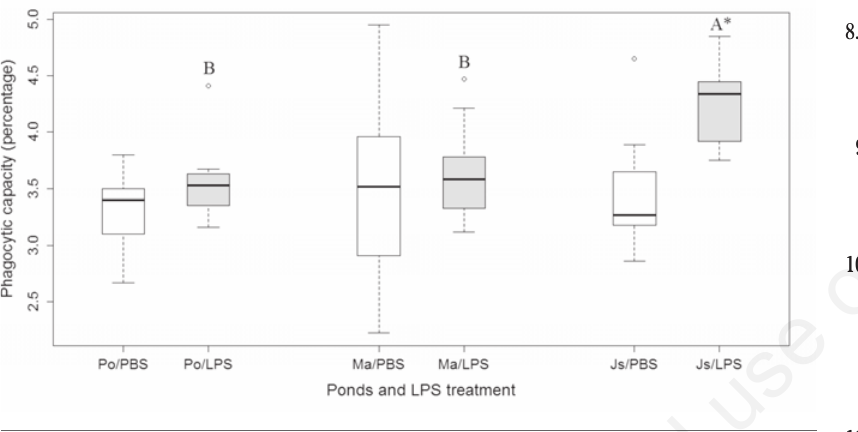
Figure 1. Phagocytic capacity of sticklebacks caged in the Haute-Vienne ponds with (grey) and without (white) injection of LPS. Po, Pontabrier, Ma, Malessard; Js, Jonchère Saint-Maurice ponds. A, B: significant differences between ponds for the same biological stress (LPS), A>B. *Significant difference between PBS and LPS conditions in a same